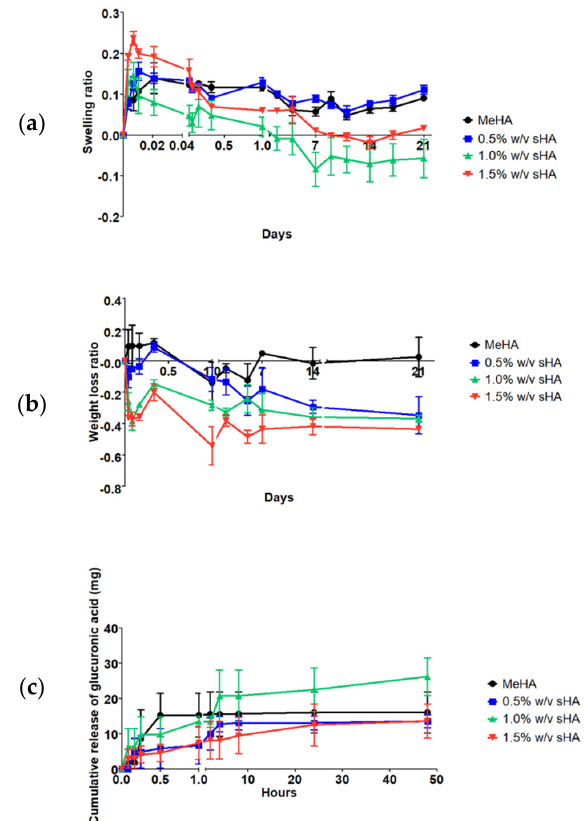
Figure 3. Physicochemical profiles of hydrogels including ( a ) swelling profiles (for 21 days), ( b ) degradation profiles (for 21 days), and ( c ) glucuronic acid release profiles for 2 days.